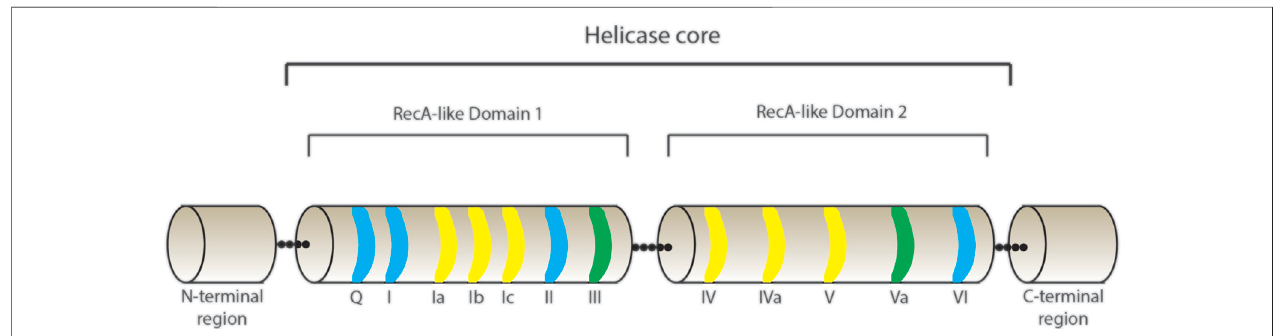
FIGURE1| SchematicrepresentationofthehelicasecoreofDEAD-boxproteins.ThehelicasecoreiscomposedoftwoRecA-likeDomains1and2connectedbya linker region. The conserved motifs presented are highlighted in blue for domains with ATP-binding and hydrolysis activity, yellow for RNA binding activity and green for domains involved in communication between ATP and RNA - binding sites.